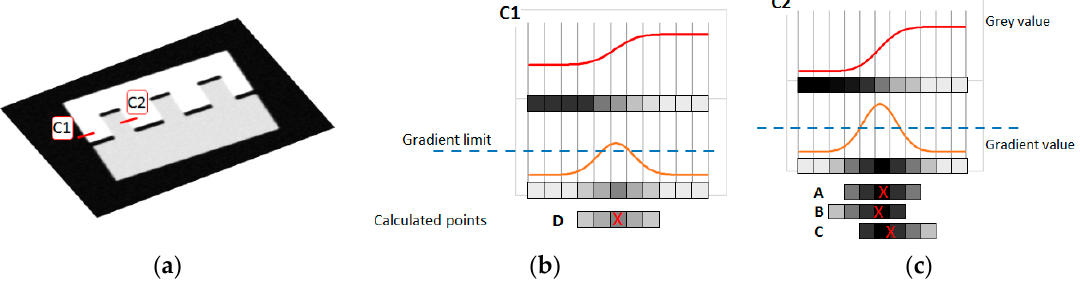
Figure 3. Suppression of no-maximum points in multi-material parts: ( a ) Profile; ( b ) situation where the right gradient limit value generates only one point; ( c ) situation where the same gradient limit generates several close points with high gradient values, justifying the need for non-maximum suppression.